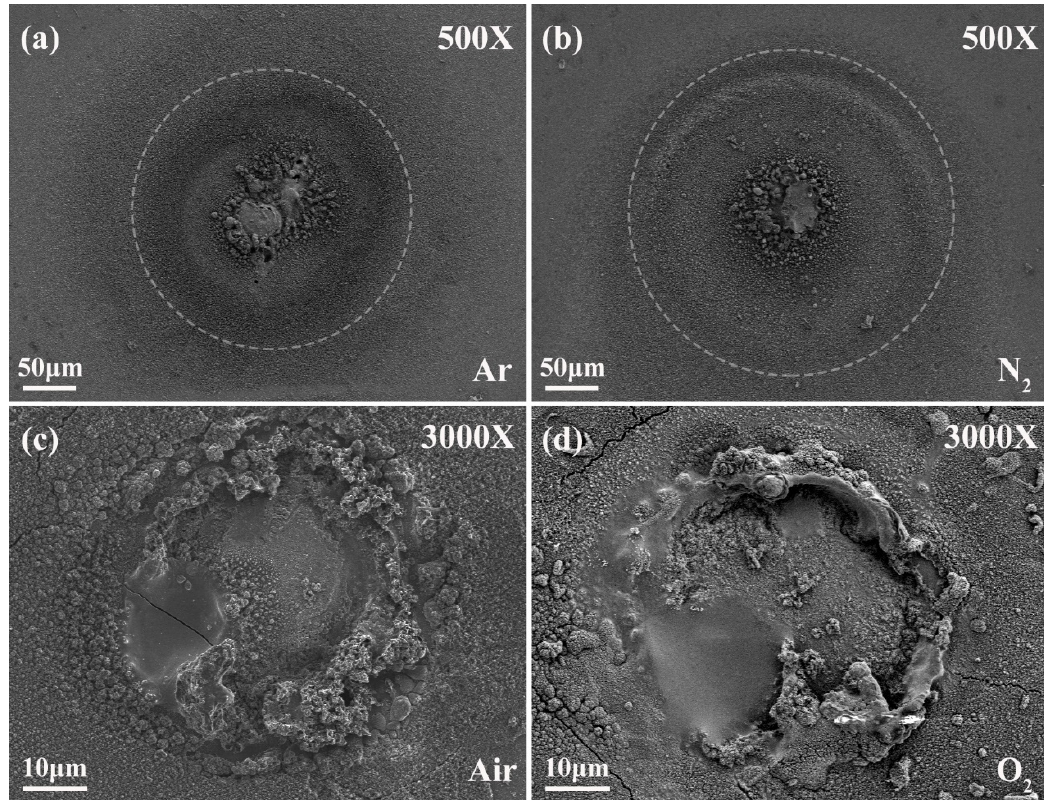
Figure 10. SEM morphology of combustion residues of Mg microparticles in inert and oxidizing atmospheres. ( a ) 500×, Ar; ( b ) 500×, N 2 ; ( c ) 3000×, Air; ( d ) 3000×, O 2 .